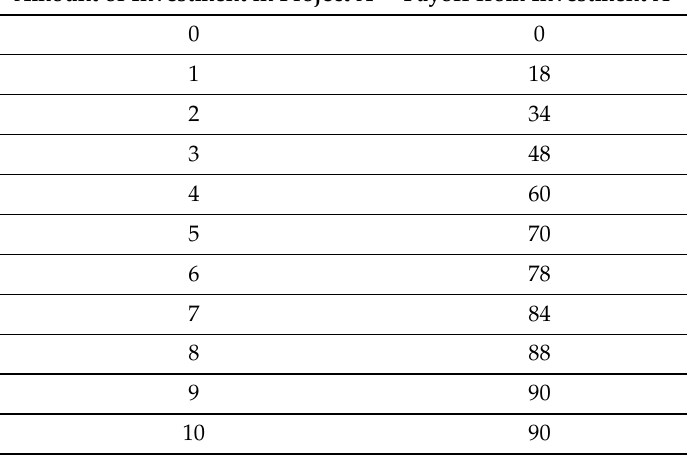
Table 1. Payoffs from Private Project A. Amount of Investment in Project A